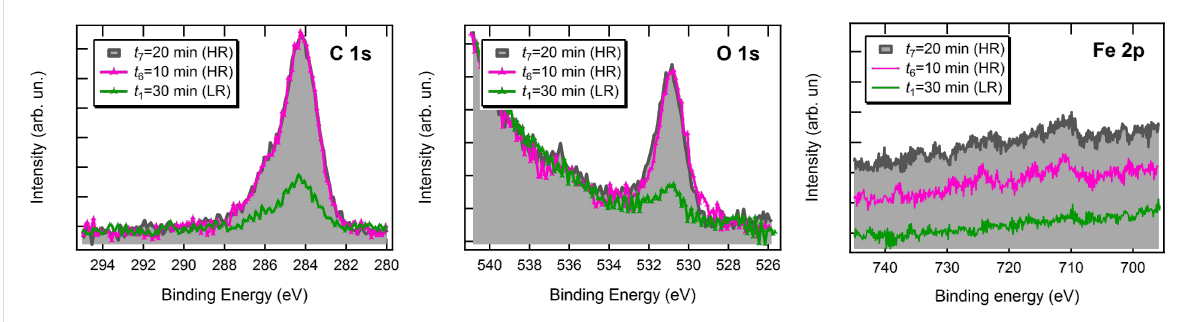
Figure 4: C 1s, O 1s and Fe 2p XPS spectra for the Au(111) substrate exposed to increasing doses of Fe(dpm) 3 .